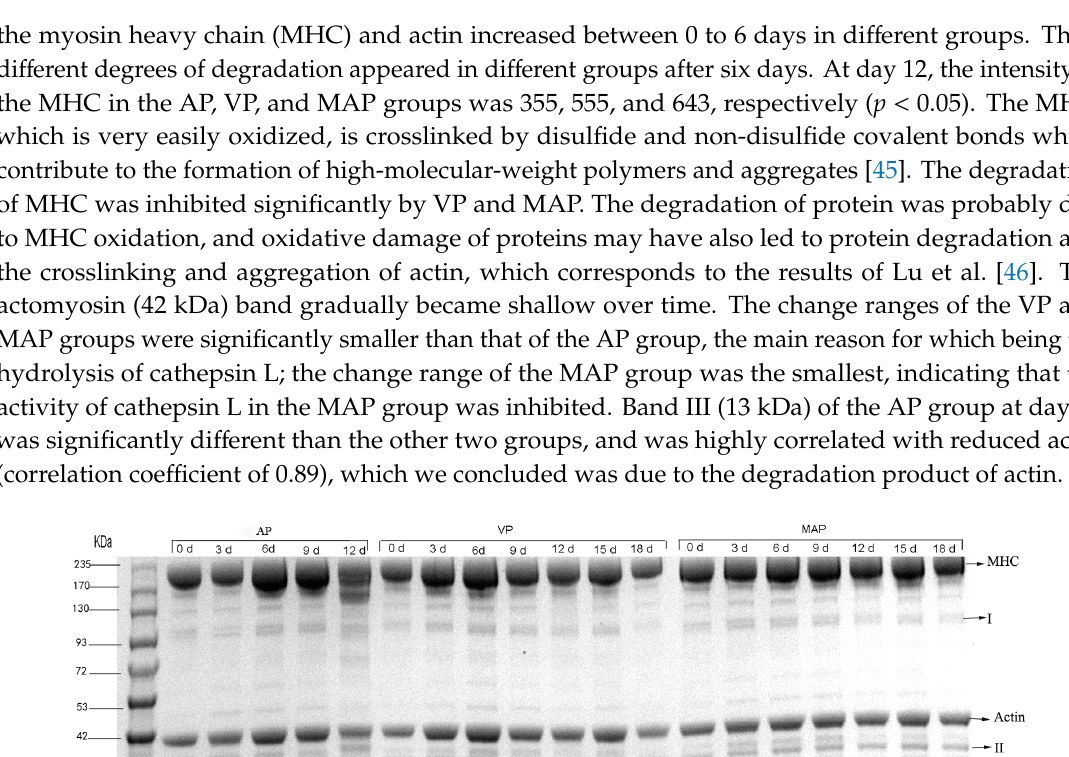
Table 2. Correlation analysis between protein oxidation and the degradation of grouper in three groups. Group Indicator of Protein Indicator of Protein Pearson Correlation